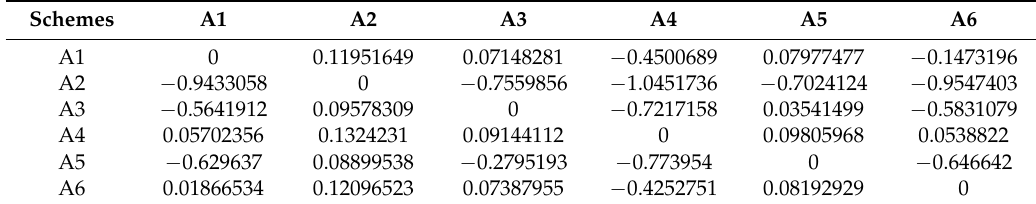
Table 6. Dominance matrix under indicator